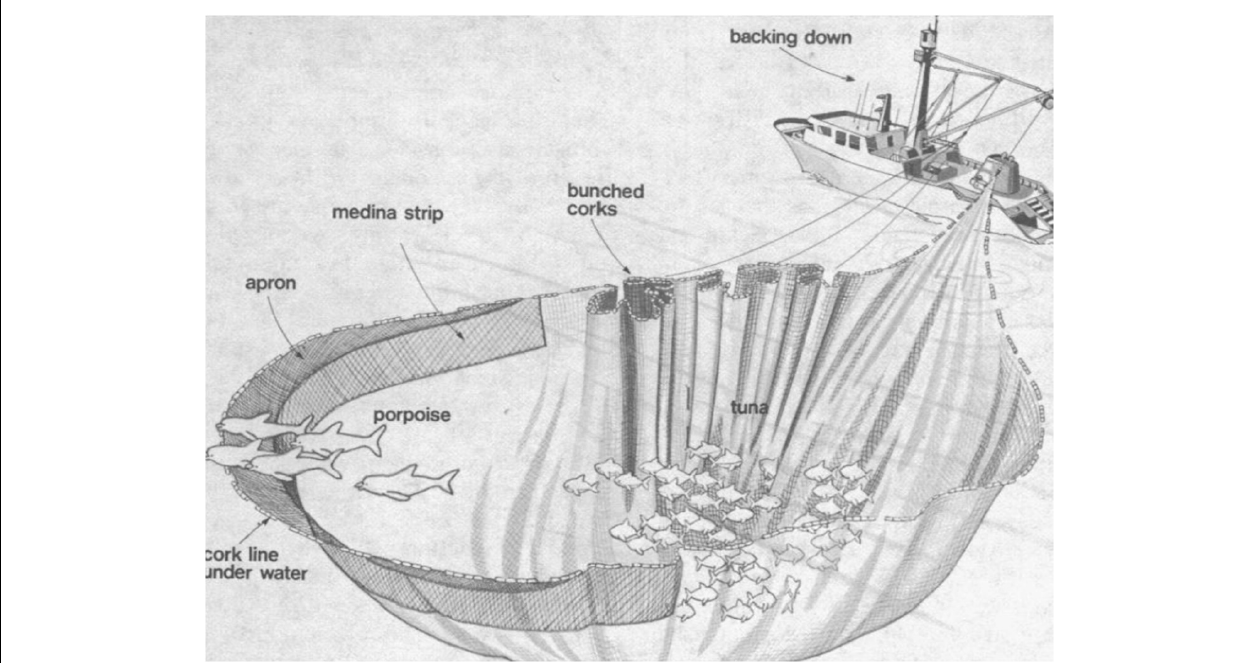
FIGURE 3 | Backdown procedure in progress. As the tuna vessel moves backward to the right in this schematic, the net is drawn into a long channel. The corkline at the far end (left) is pulled under water 1–3 m, and the dolphins (referred to as “porpoise” in this figure, and in the early years of the fishery) escape. The Medina panel (labeled “medina strip” in this figure) and Apron are panels of netting with smaller mesh size to prevent dolphins from becoming entangled as they escape. Source: Leeper, 1976.